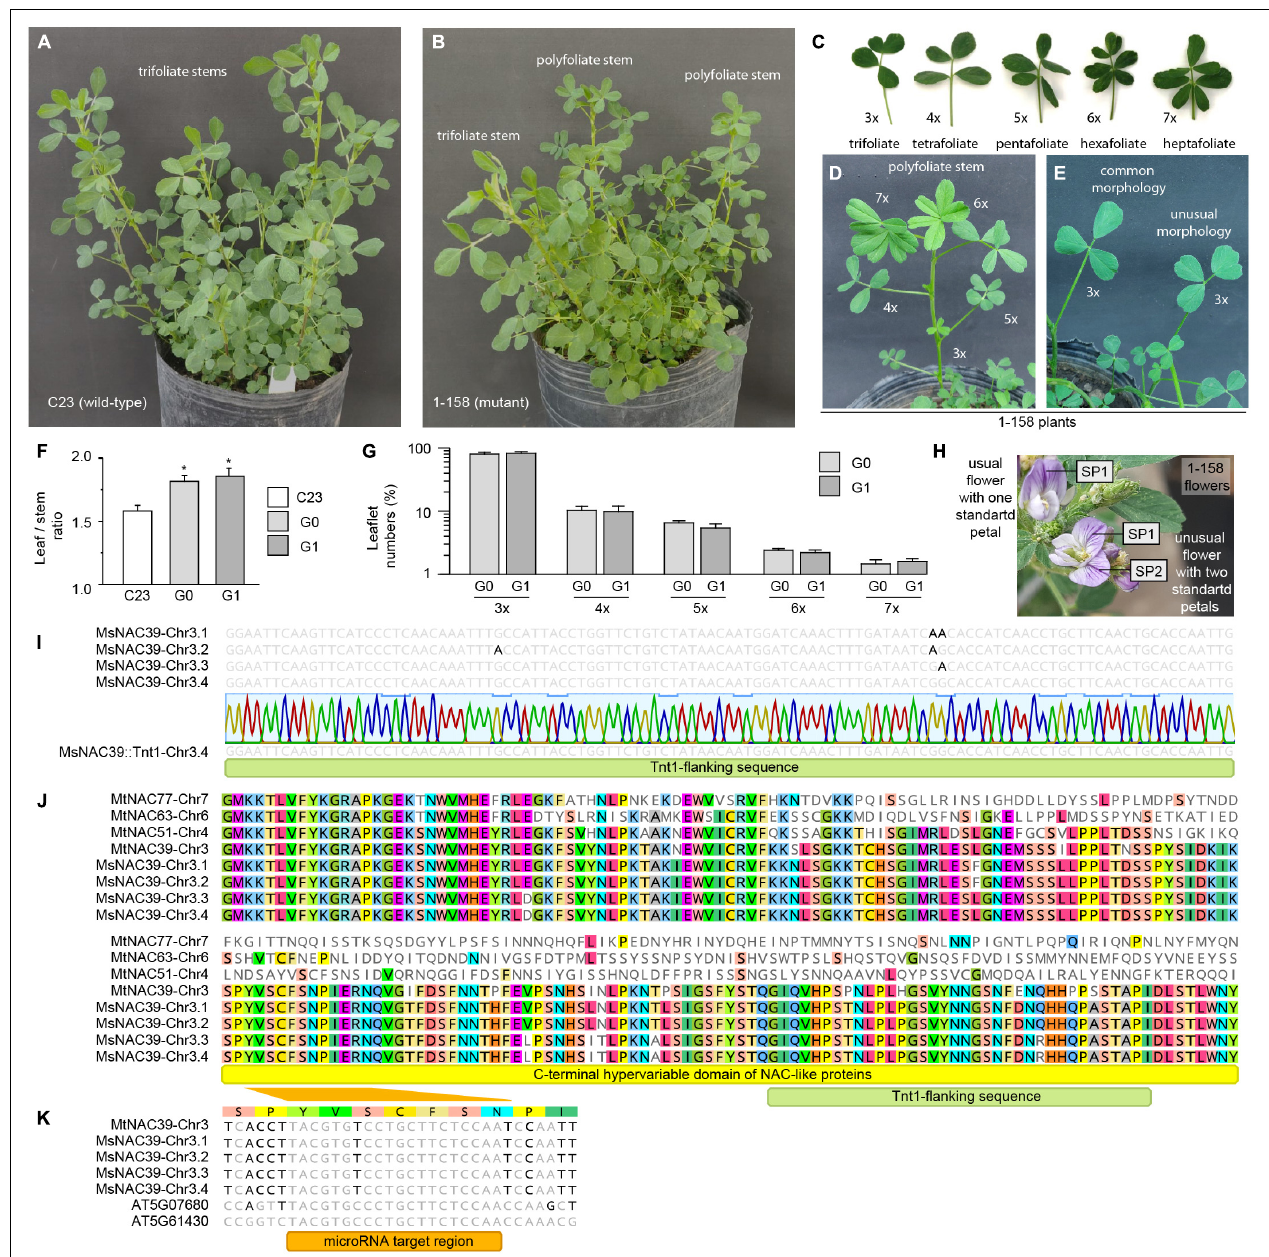
FIGURE 1 | Identification of a dominant mutation conferring multifoliate leaves in cultivated alfalfa via Tnt1 . During a screening of dominant mutations with visible phenotype from an alfalfa Tnt1 insertion mutant library using the wild-type highly regenerative alfalfa clone C23 (García et al., 2014), we identified a mutant (1–158, mfl ) plant displaying both usual trifoliate stems (A,B) and unusual polyfoliate leaves (B) . These mutant plants show trifoliate to heptafoliate leaves (C) , polyfoliate leaves with different number of leaflets (D) , and tetrafoliate leaves with unusual morphologies (E) . When comparing clonally propagated individual plants derived from the wild-type clone (C23), the original mutant clone 1–158 (G0) and its first generation offspring (G1), we observed that the mfl mutation induces a higher leaf-to-stem ratio (F) and higher numbers of leaflets (G) . The mfl mutant also shows flowers with extra petals (H) . In these experiments, the cuts were performed at 8 cm from the soil and plants were harvested periodically (every 60 days) to prevent their flowering and evaluate their leaf/stem ratio and number of leaflets for 2 years. The values are the average for this period. Wild-type and mutant plants were intercrossed by hand. Wild-type plants contains four different alleles of MsNAC39 and Tnt1 is inserted into this gene on chromosome 3.4 in mfl mutant plants (I) . Multiple alignment of the partial amino acid sequences of MsNAC39 protein and its closely related proteins in M. truncatula (MtNAC77, MtNAC63, and MtNAC51) showing that the Tnt1 insertion is localized in the C-terminal hypervariable domain of the MsNAC39 protein (J) . The microRNA target region of Arabidopsis NAC-like genes AT5G61430 and AT5G07680 is conserved in the MsNAC39 alleles (K) . Values are mean ± SEM ( n = 25). Statistical analysis was carried out with Student’s t -test (* p < 0.05).